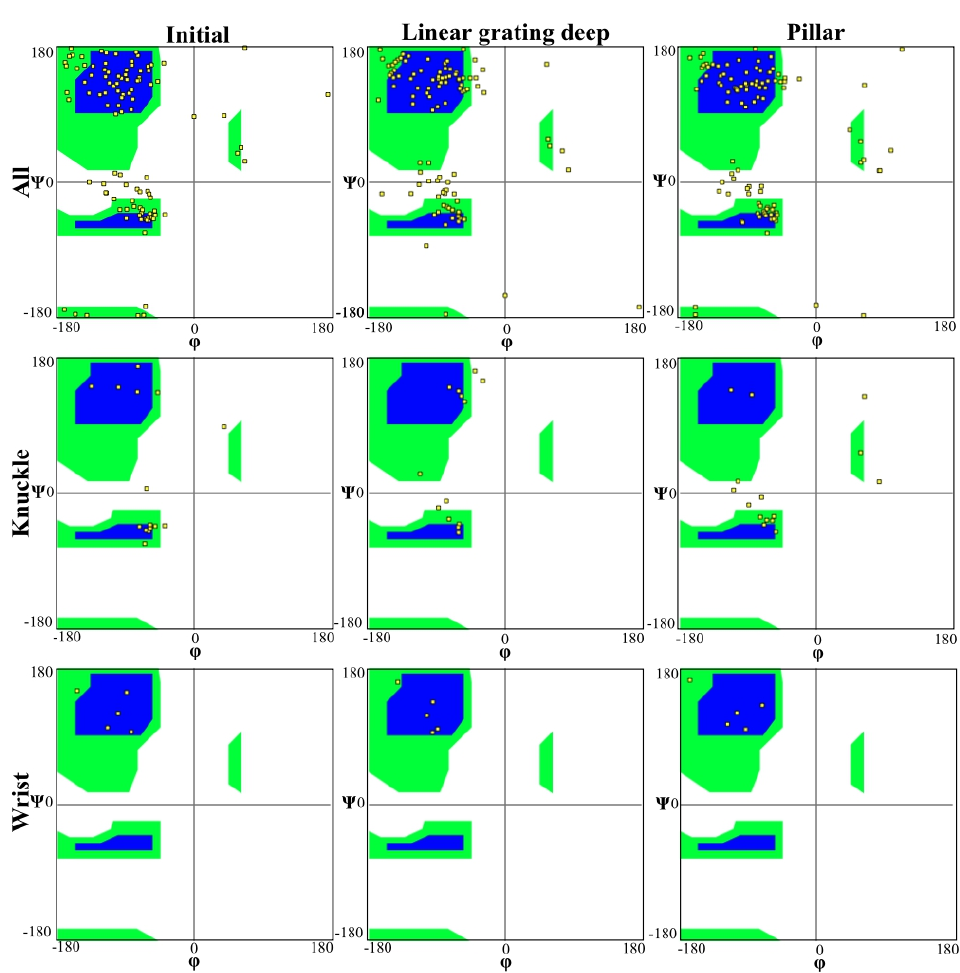
Figure 6. Ramachandran plots comparing different nanoscale topographies.